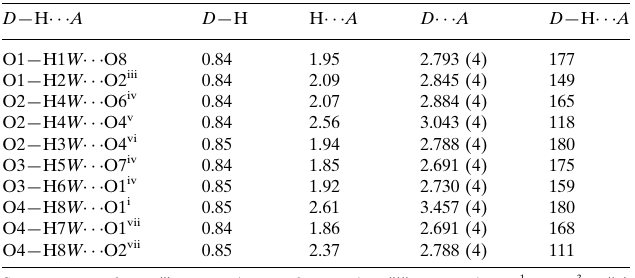
Hydrogen-bond geometry (A˚ , (cid:2)